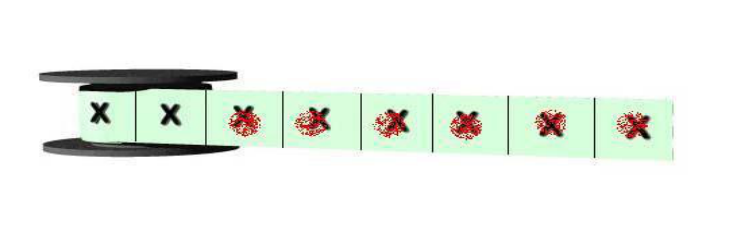
Figure 6: Shows a spool for candidate X with marked sections. The number of the red marks indicates the number of votes for candidate